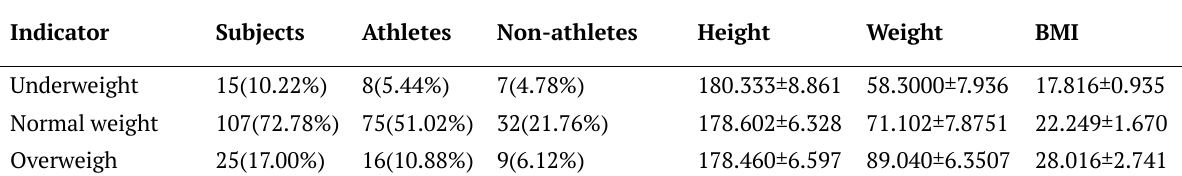
Table 1. Distribution of students into groups and analyzed anthropometric characteristics (average and standard